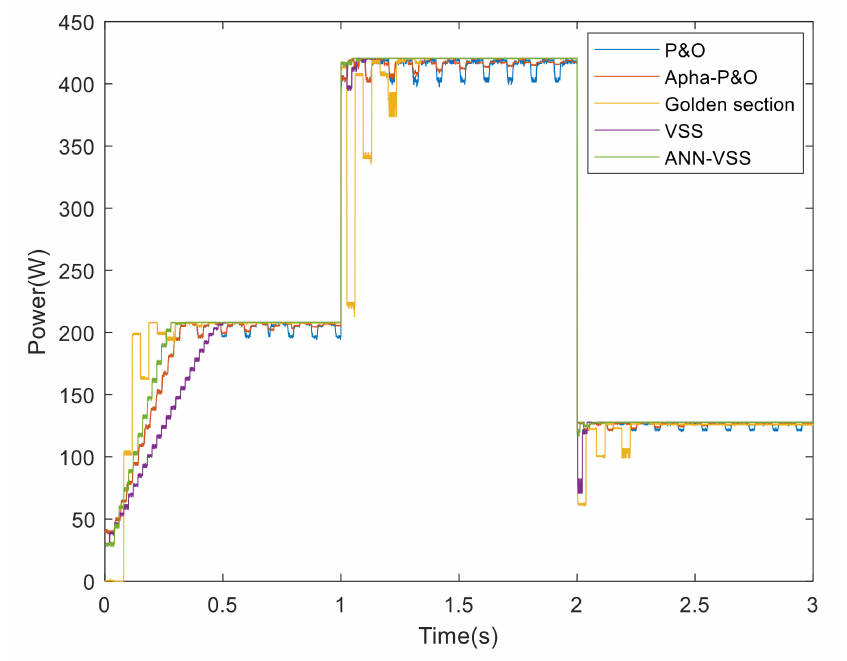
Figure 13. Experimental tracking waveforms of five compared MPPT methods under varying irradiation